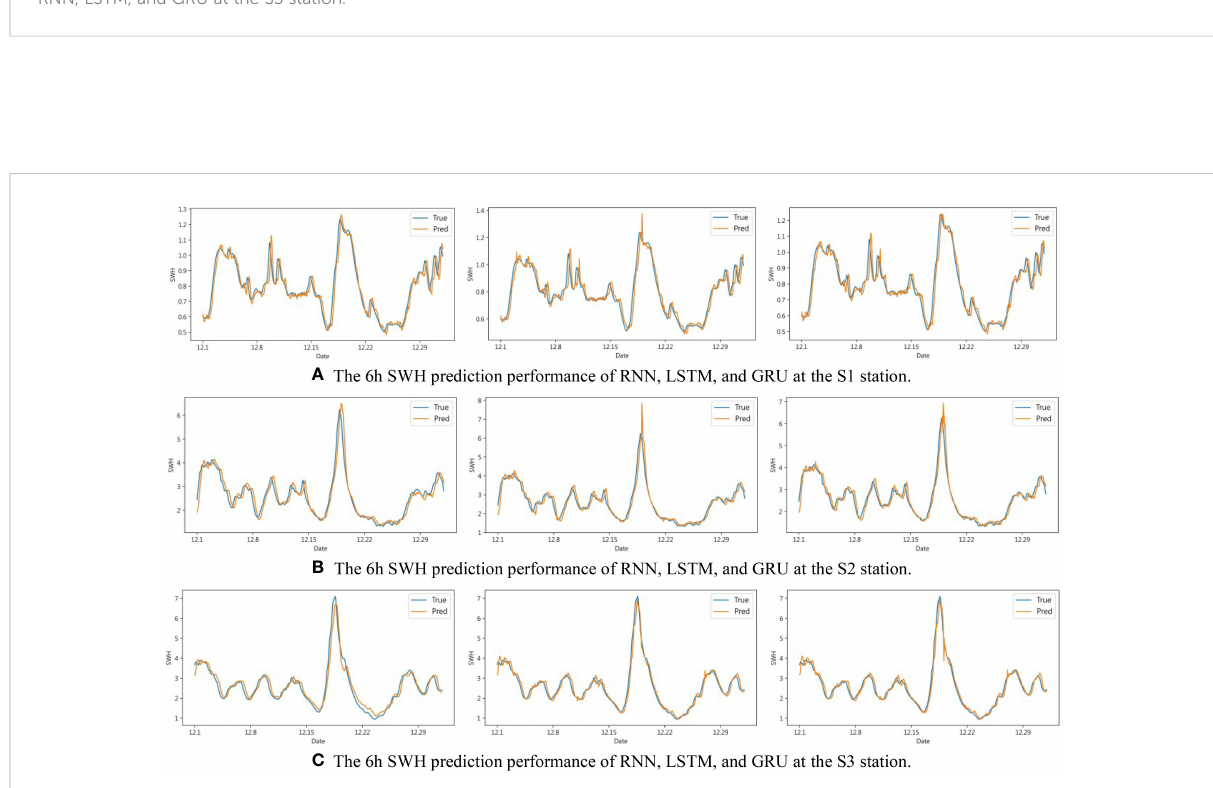
FIGURE 7 6h SWH prediction performance of RNN, LSTM, and GRU at S1, S2, and S3. (A) The 6h SWH prediction performance of RNN, LSTM, and GRU at the S1 station. (B) The 6h SWH prediction performance of RNN, LSTM, and GRU at the S2 station. (C) The 6h SWH prediction performance of RNN, LSTM, and GRU at the S3 station.